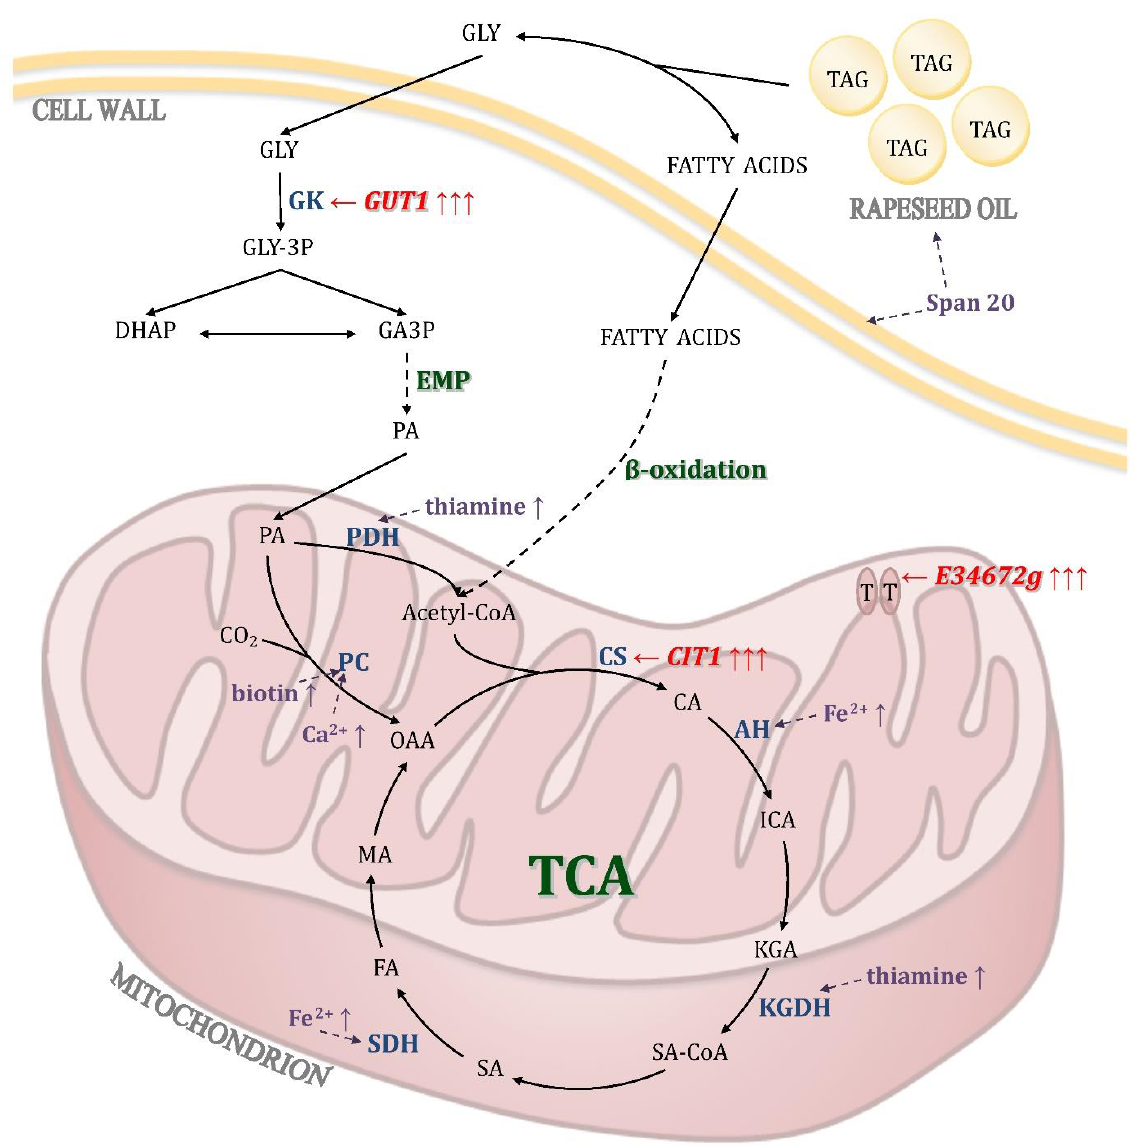
Figure 7. Scheme of metabolic pathways involved in conversion of glycerol and rapeseed oil to KGA by Yarrowia lipolytica CBS146773 and the putative effect of selected factors on the efficiency of